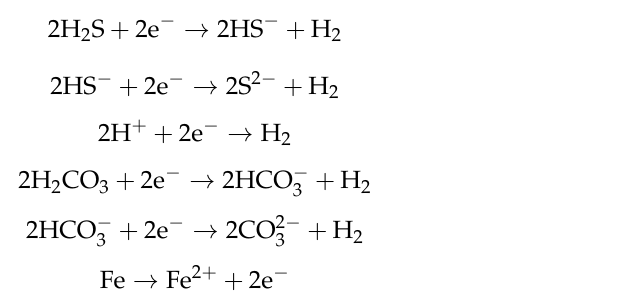
Figure 20. The safe service life of T95 steel in the liquid phase considering pitting corrosion.